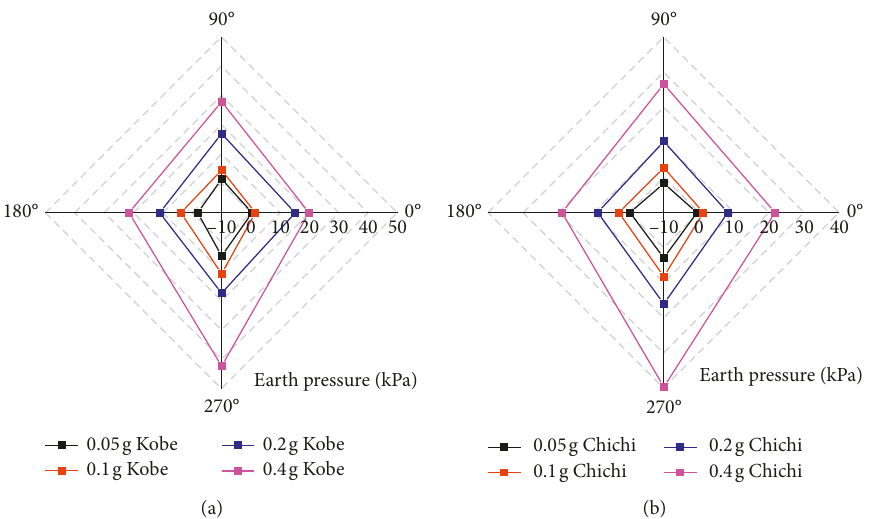
Figure 20: Maximum earth pressure distribution on soil-structure interface. (a) The excitation of Kobe motions. (b) The excitation of Chichi motions.